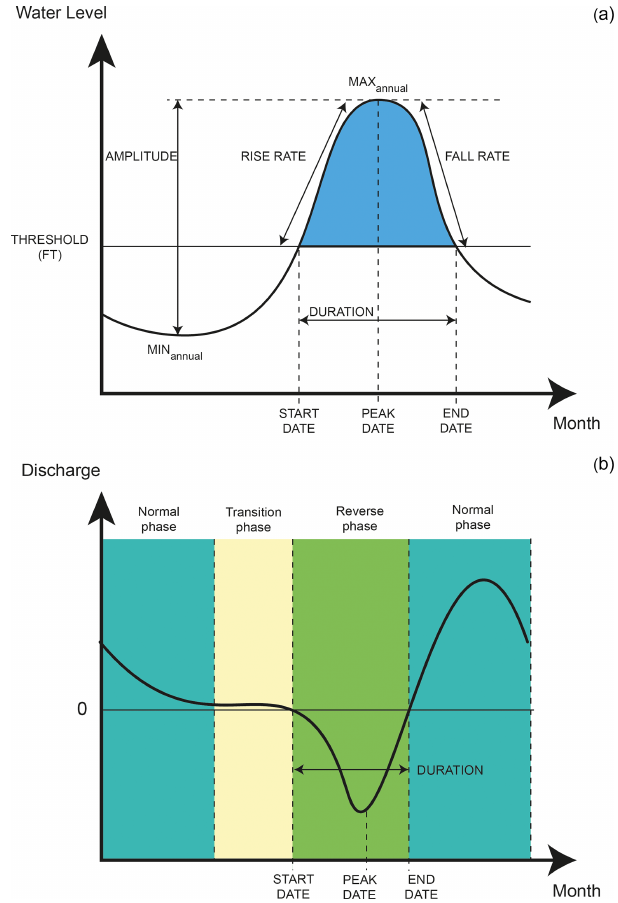
Figure 3. (a) Schematic of flood pulse variables in virtual annual water level plot in the Cambodian floodplains. (b) Schematic of the various phases at Prek Kdam observed through a typical annual dis- charge plot. Negative discharge values indicate reverse flow from the Mekong to the Tonle Sap